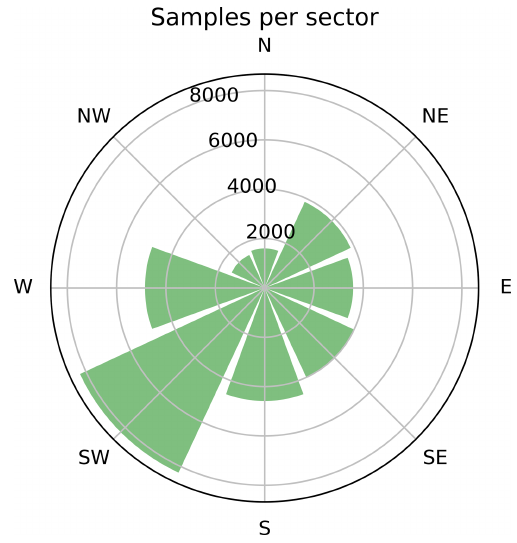
Figure 3. Number of samples per (main) upstream wind sector at time step t 0 within the testing set.